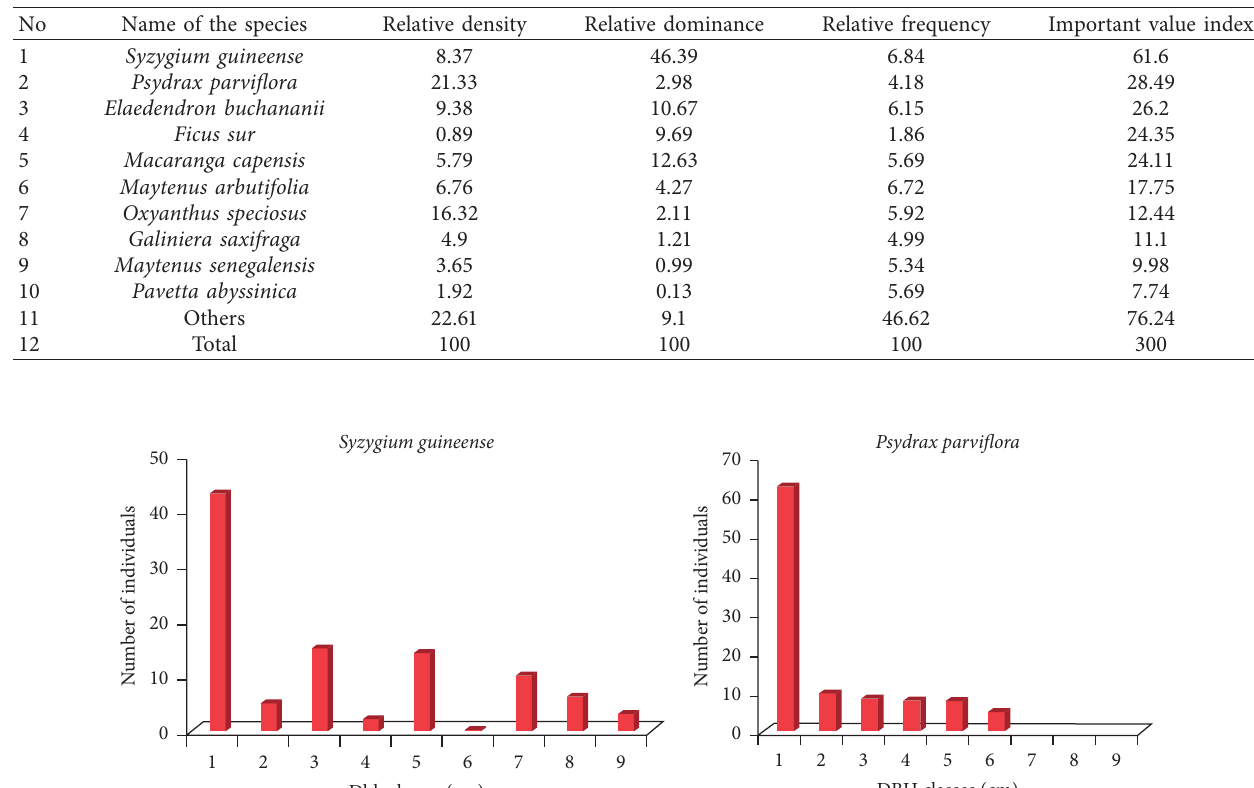
Table 8: The relative density, relative dominance, relative frequency, and important value index of tree/shrub species in Wurg